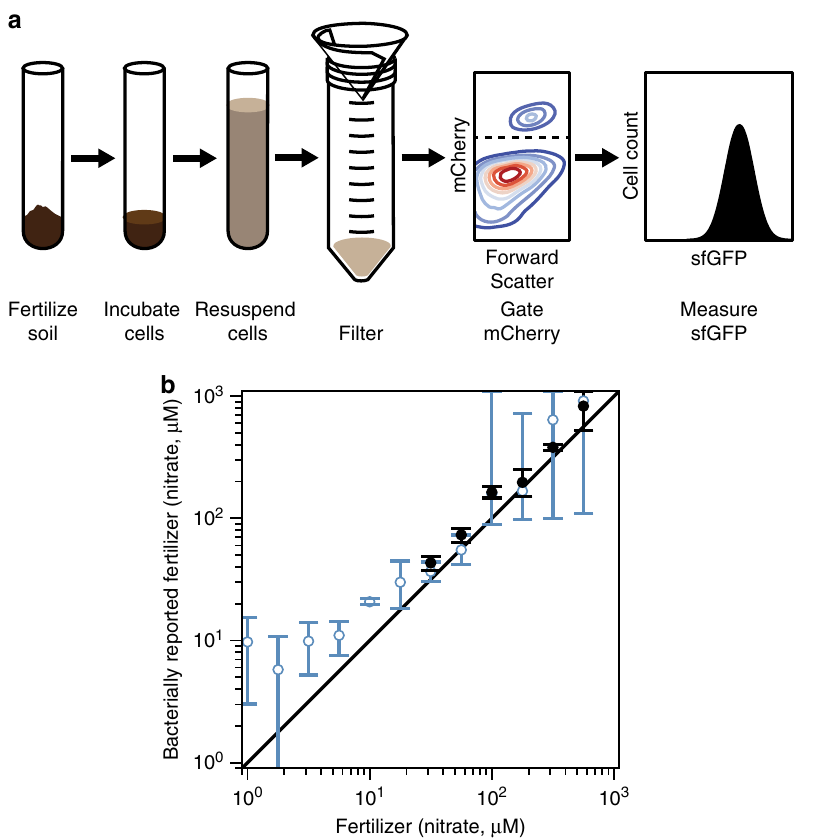
Fig. 6 TCS tuning expands the detection range of an engineered soil fertilizer biosensor. a Experimental protocol for the incubation of bacteria with fertilized soil, subsequent puri fi cation via fi ltration, selection by mCherry fl uorescence, and measurement of sfGFP levels (Methods). b Soil was fertilized with different amounts of nitrate as speci fi ed by the manufacturer. The level of fertilization was then measured with a B. subtilis strain expressing the NarXL-YdfI TCS with wild-type (black) and C415R (blue) NarX variants (Fig. 2a; Supplementary Fig. 12). This was compared to a previously measured standard curve of nitrate response to calculate a bacterially reported nitrate concentration from the fertilizer (Supplementary Note 2; Supplementary Fig. 12). The relationship between the actual and bacterially reported values is shown. Points represent the mean and error bars the SEM of experiments